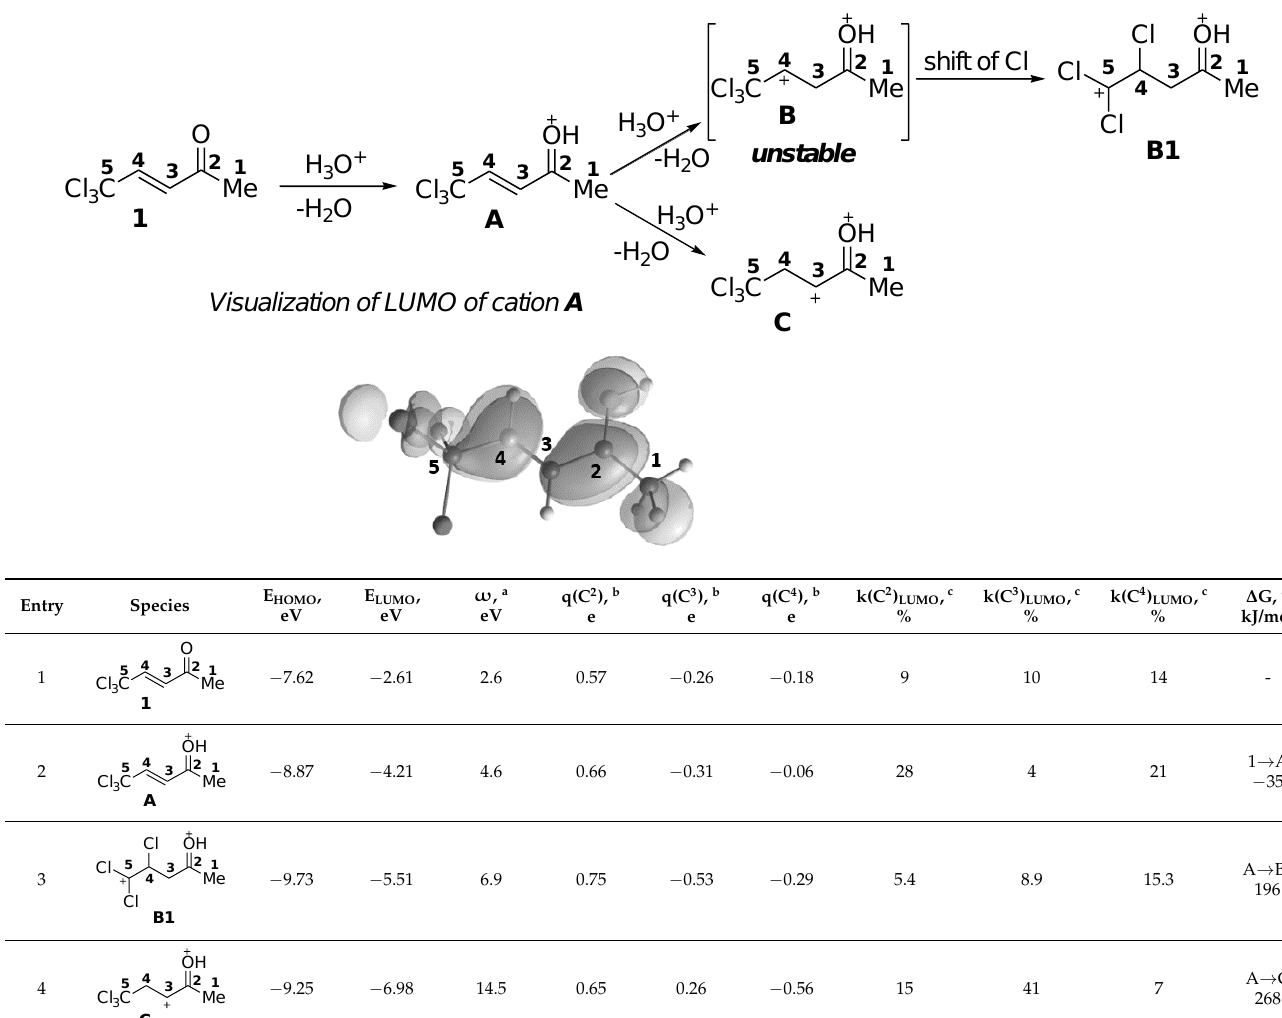
Table 2. Selected calculated (DFT) electronic characteristics of the protonated forms A , B , C of CCl 3 -enone 1 ,and values of Gibbs energies of protonation reactions (ΔG, kJ/mol).